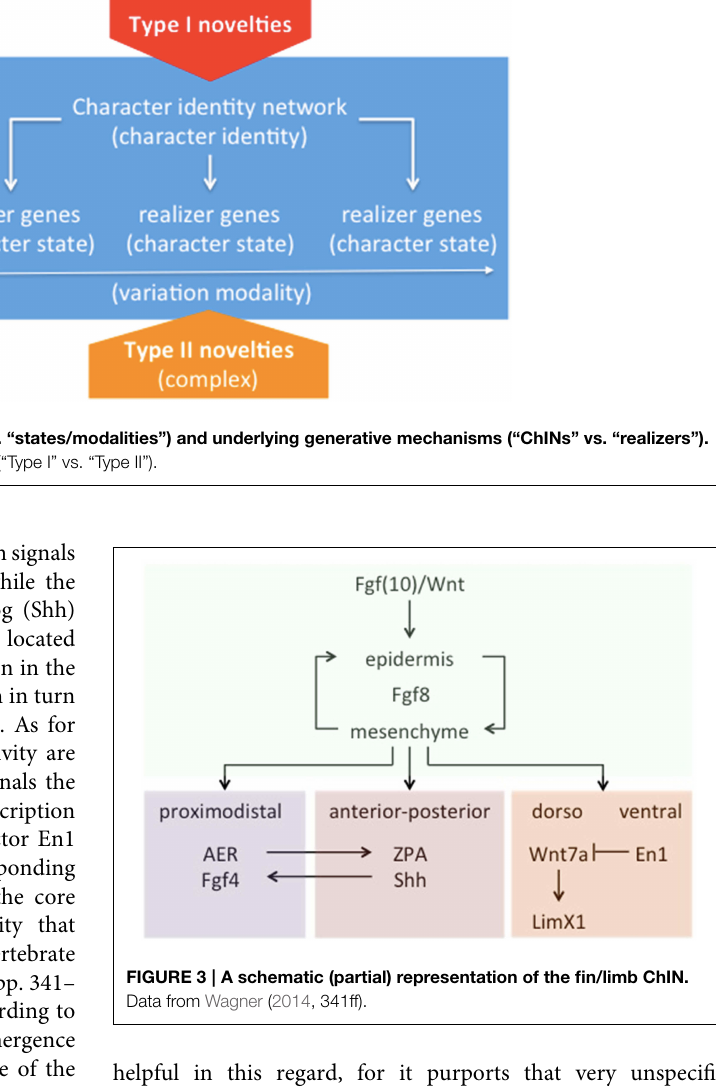
helpful in this regard, for it purports that very